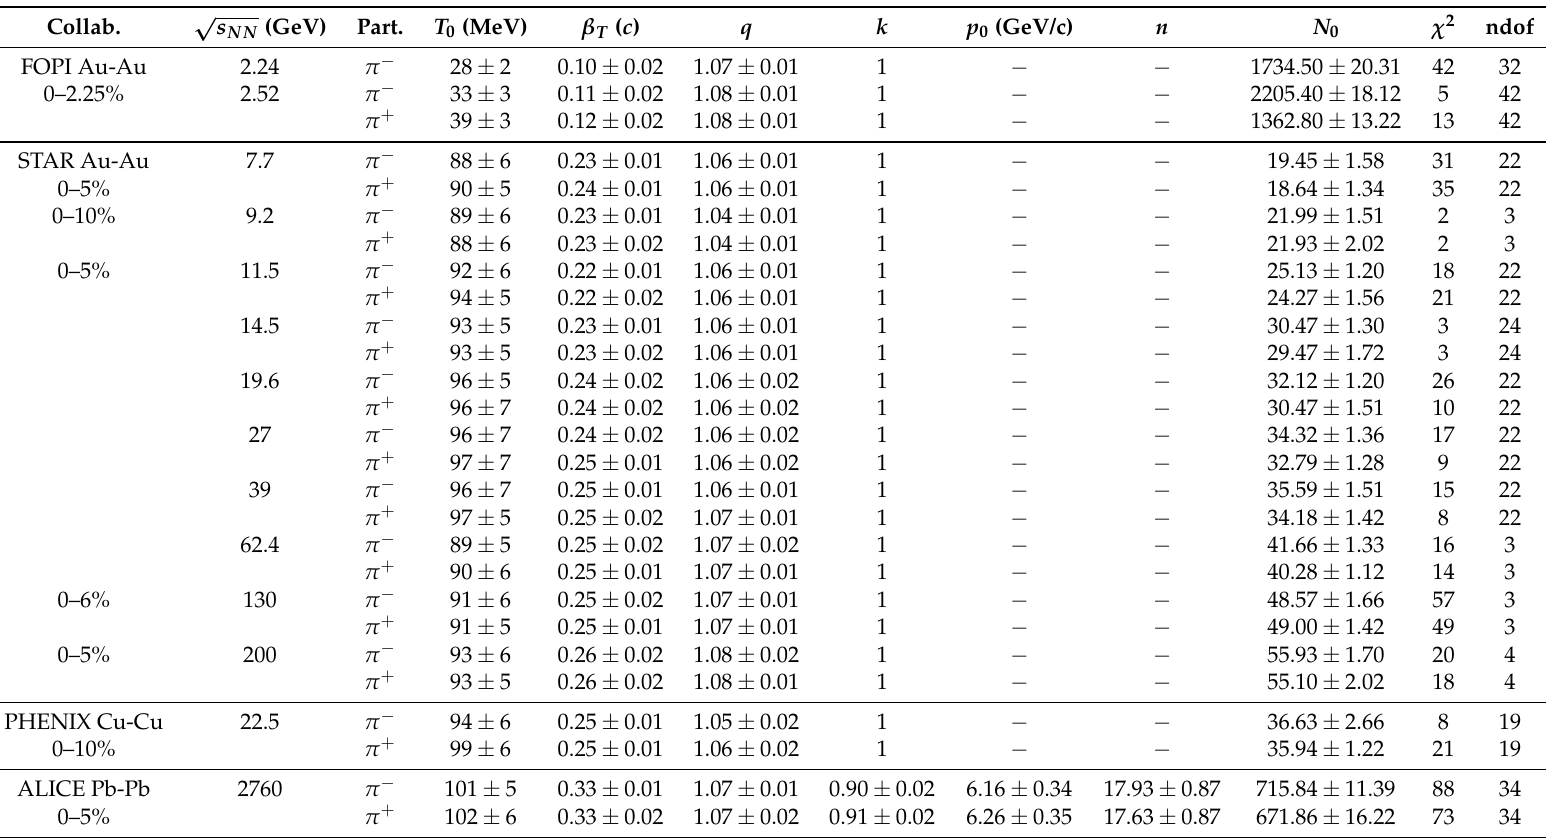
Table A4. Values of T 0 , β T , q , k , p 0 , n , N 0 , χ 2 , and ndof corresponding to the dashed (dot-dashed) curves for π − ( π + ) spectra in Figure